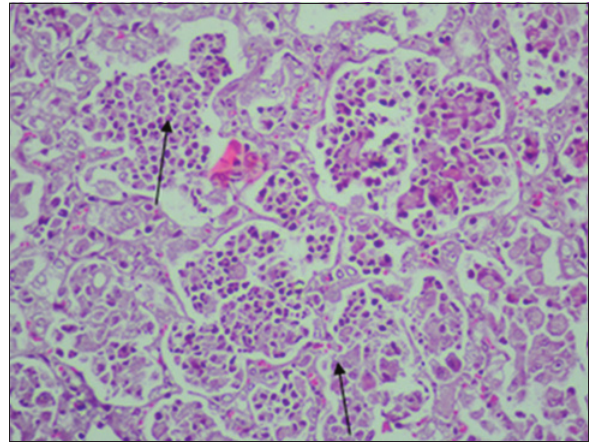
Figure-4: Alveolar epithelial cell proliferation and lymphocyte infiltration in the lungs of ovine pulmonary adenocarcinoma affected sheep (arrow) (H and E,